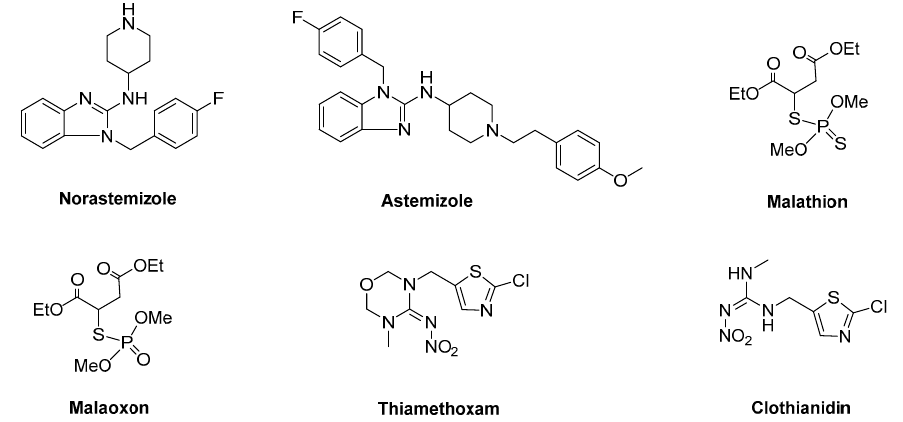
Figure 1. Chemical structures of malathion, malaoxon, thiamethoxam, clothianidin, astemizole, and norastemizole.